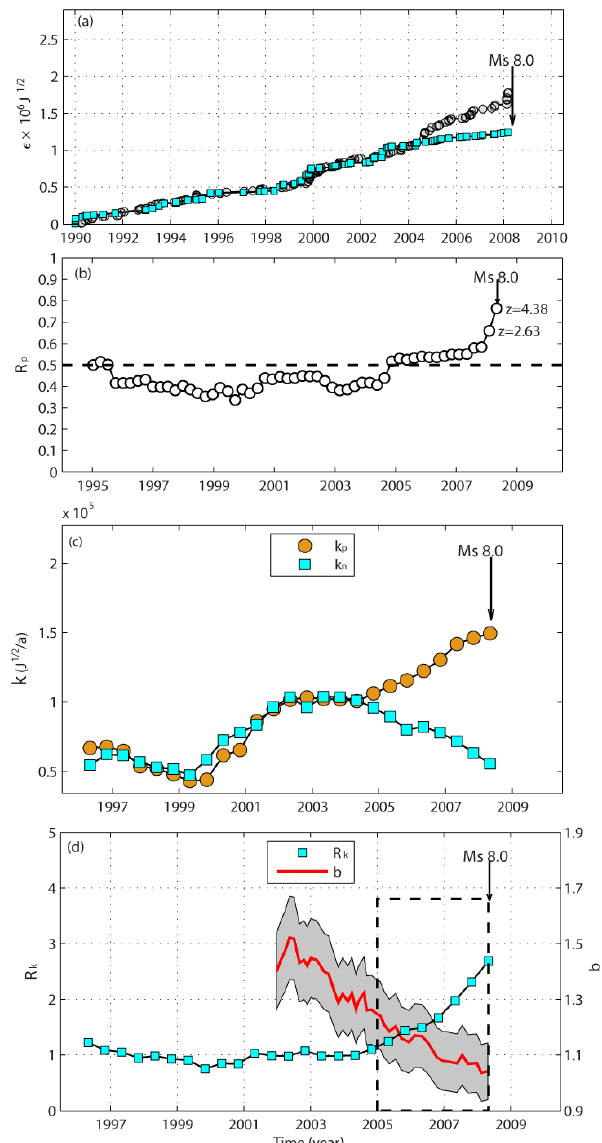
Figure 4. (a) Cumulative seismic strain release curve. The line with (cid:13) symbols is for PEQs, and the line with (cid:3) symbols is for NEQs. (b) R p vs. time, with a moving 6-year time window moved by 6 months. (c) The time rate k of CSSR vs. time for both PEQs and NEQs. The orange circles show the time rate k for PEQs, and the cyan squares are for NEQs, with a moving 6-year time window moved by 6 months. (d) R k (cyan squares) and b value (red line) as a function of time. The grey area indicates the 95% confidence limit of the b value. The downward arrow shows the occurrence of the Wenchuan earthquake.